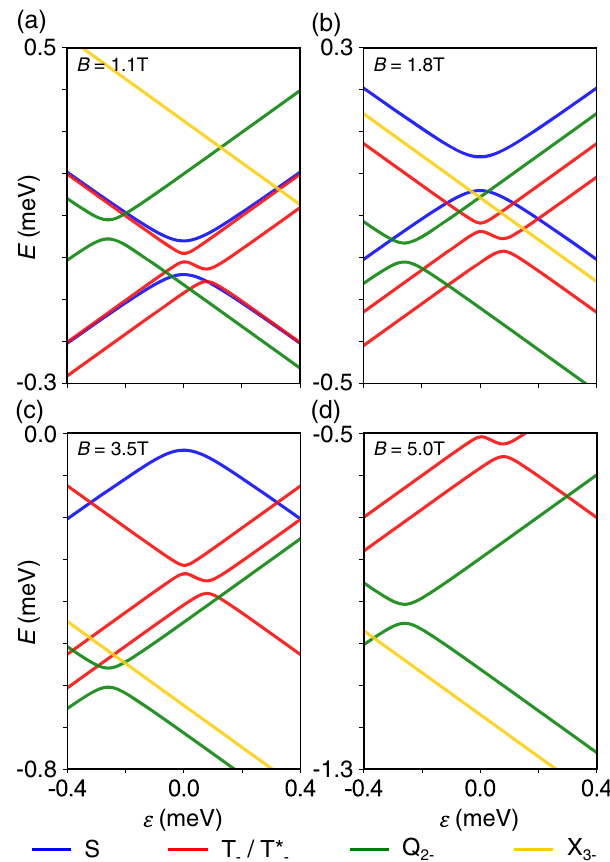
FIG. 5. Energy levels of the lowest-energy spin state of each spin manifold with S ≤ 3 at various magnetic fields as a function of detuning ε . The singlet states (S) are shown in blue, the triplet states (T − ) in red, the quintet states (Q 2 − ) in green, and the septet state (X 3 − ) in yellow. Each panel shows the energy spectrum at the magnetic field indicated in the upper left of the panel and has the following physical relevance for the system: (a) Onset of quintet-triplet spin blockade and origin of double peak in Fig. 6. (b) Quintet-triplet spin blockade. (c) Lifting of spin blockade as the quintet anticrossing becomes the ground state. (d) Septet- quintet spin blockade.